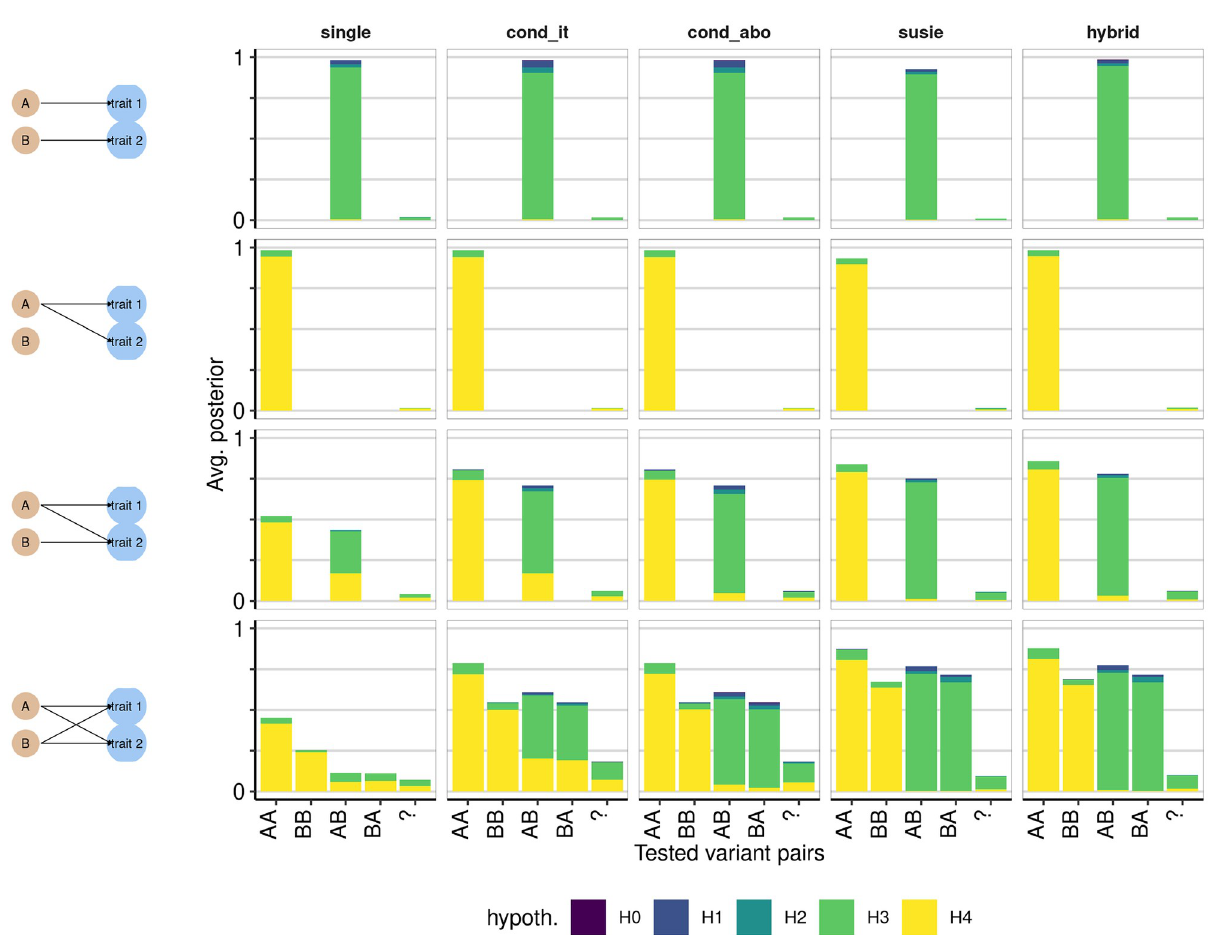
Fig 1. Average posterior probability distributions in simulated data. The four classes of simulated datasets are shown in four rows, with the scenario indicated in the left hand column. For example, the top row shows a scenario where traits 1 and 2 have distinct causal variants A and B. Columns indicate the different analysis methods, with susie indicating SuSiE, cond_it indicating that coloc-conditioning was run in iterative mode, and cond_abo indicating it was run in “all but one” mode. For each simulation, the number of tests performed is at most 1 for “single”, or equal to the product of the number of signals detected for the other methods. For each test, we estimated which pair of variants were being tested according to the LD between the variant with highest fine-mapping posterior probability of causality for each trait and the true causal variants A and B. If r 2 > 0.5 between the fine-mapped variant and true causal variant A, and r 2 with A was higher than r 2 with B, we labeled the test variant A, and vice versa for B. Where at least one test variant could not be unambigously assigned, we labelled the pair “?”. The total height of each bar represents the proportion of comparisons that were run for that variant pair, out of the number of simulations run, and typically does not reach 1 because there is not always power to perform all possible tests. Note that because we do not limit the number of tests, the height of the bar has the potential to exceed 1, but did not do so in practice. The shaded proportion of each bar corresponds to the average posterior for the indicated hypothesis, defined as the ratio of the sum of posterior probabilities for that hypothesis to the number of simulations performed. Recall that H 0 indicates no associated variants for either trait, H 1 and H 2 a single causal variant for traits 1 and 2 respectively, H 3 and H 4 that both traits are associated with either distinct or shared causal variants, respectively. Each simulated region contains 1000